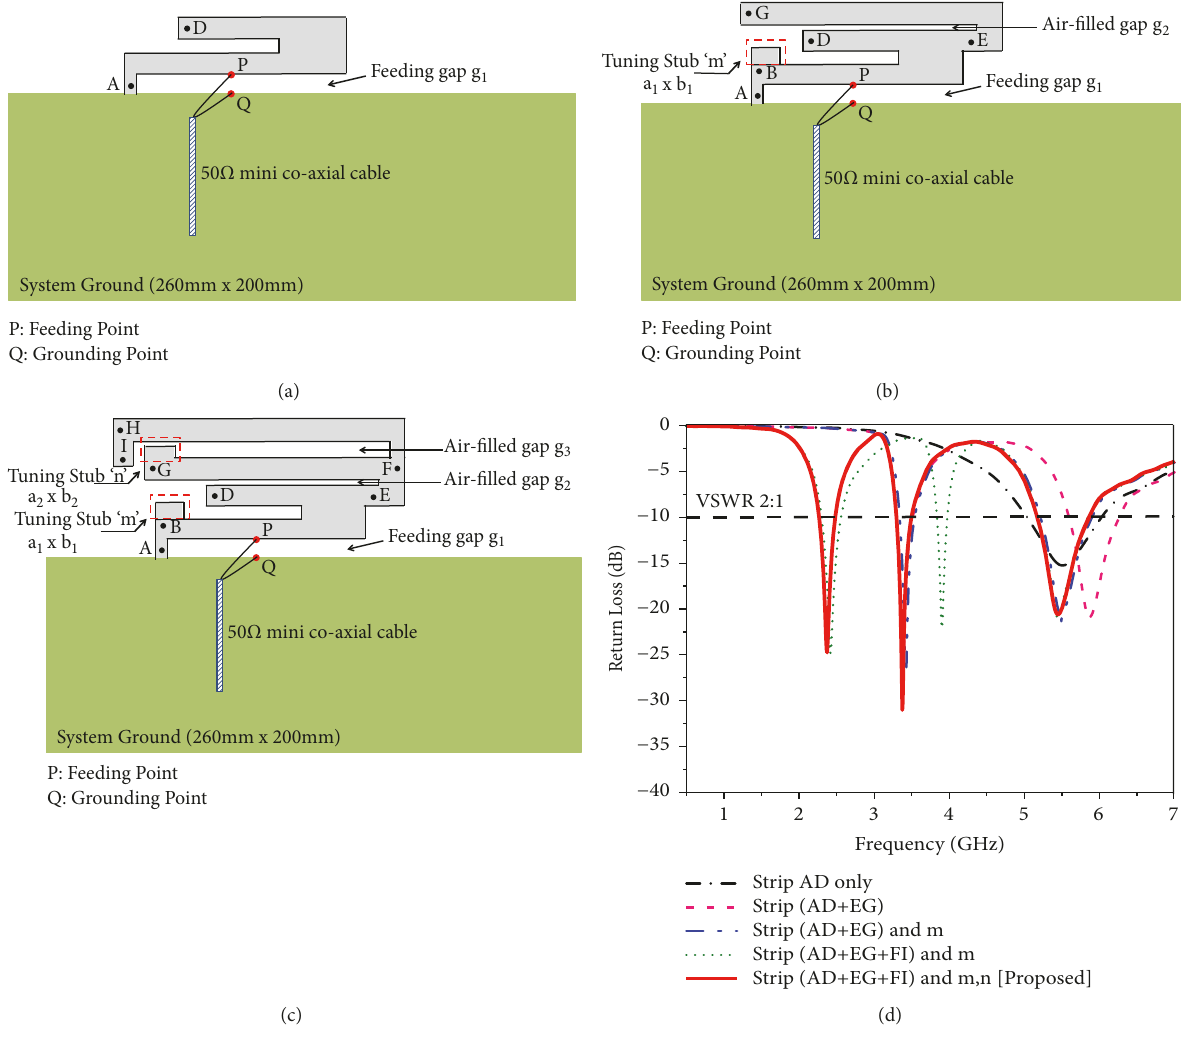
Figure 1: Design and working process of the proposed monopole